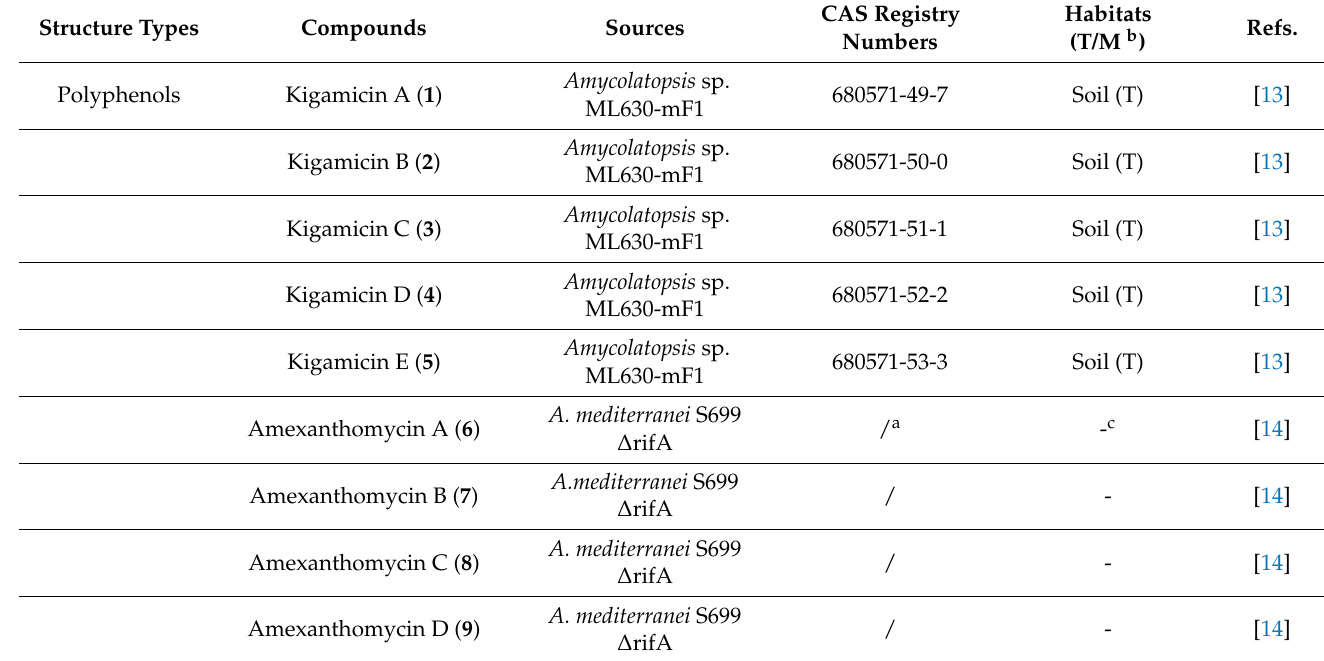
Table 1. Secondary metabolites with sources, CAS registry numbers, and habitats from the genus Amycolatopsis during 1990–2020. Structure